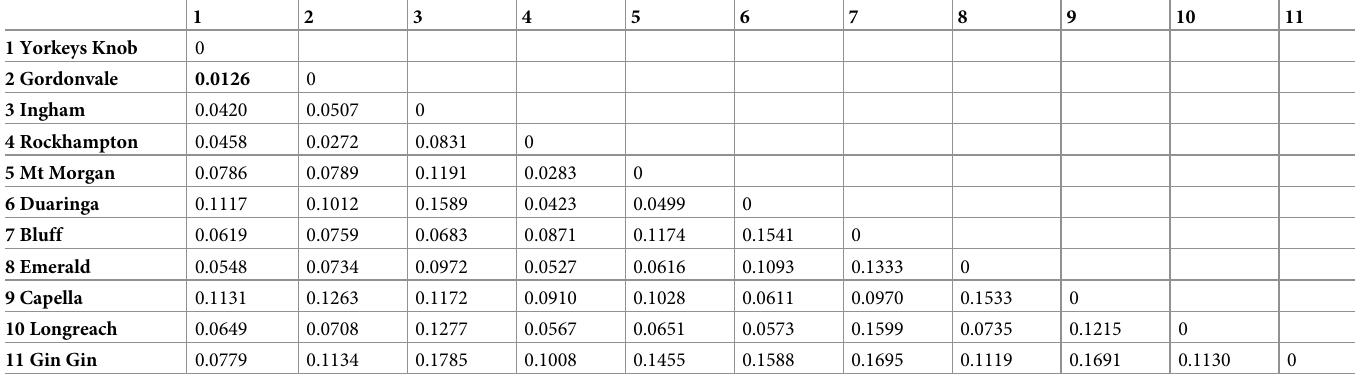
Table 4. Pairwise FST estimates for eleven samples of Aedes aegypti from Queensland, Australia. Bold indicates no significant differentiation (Table modified from Rasˇi ć et al . [35] to include data from Gin Gin).